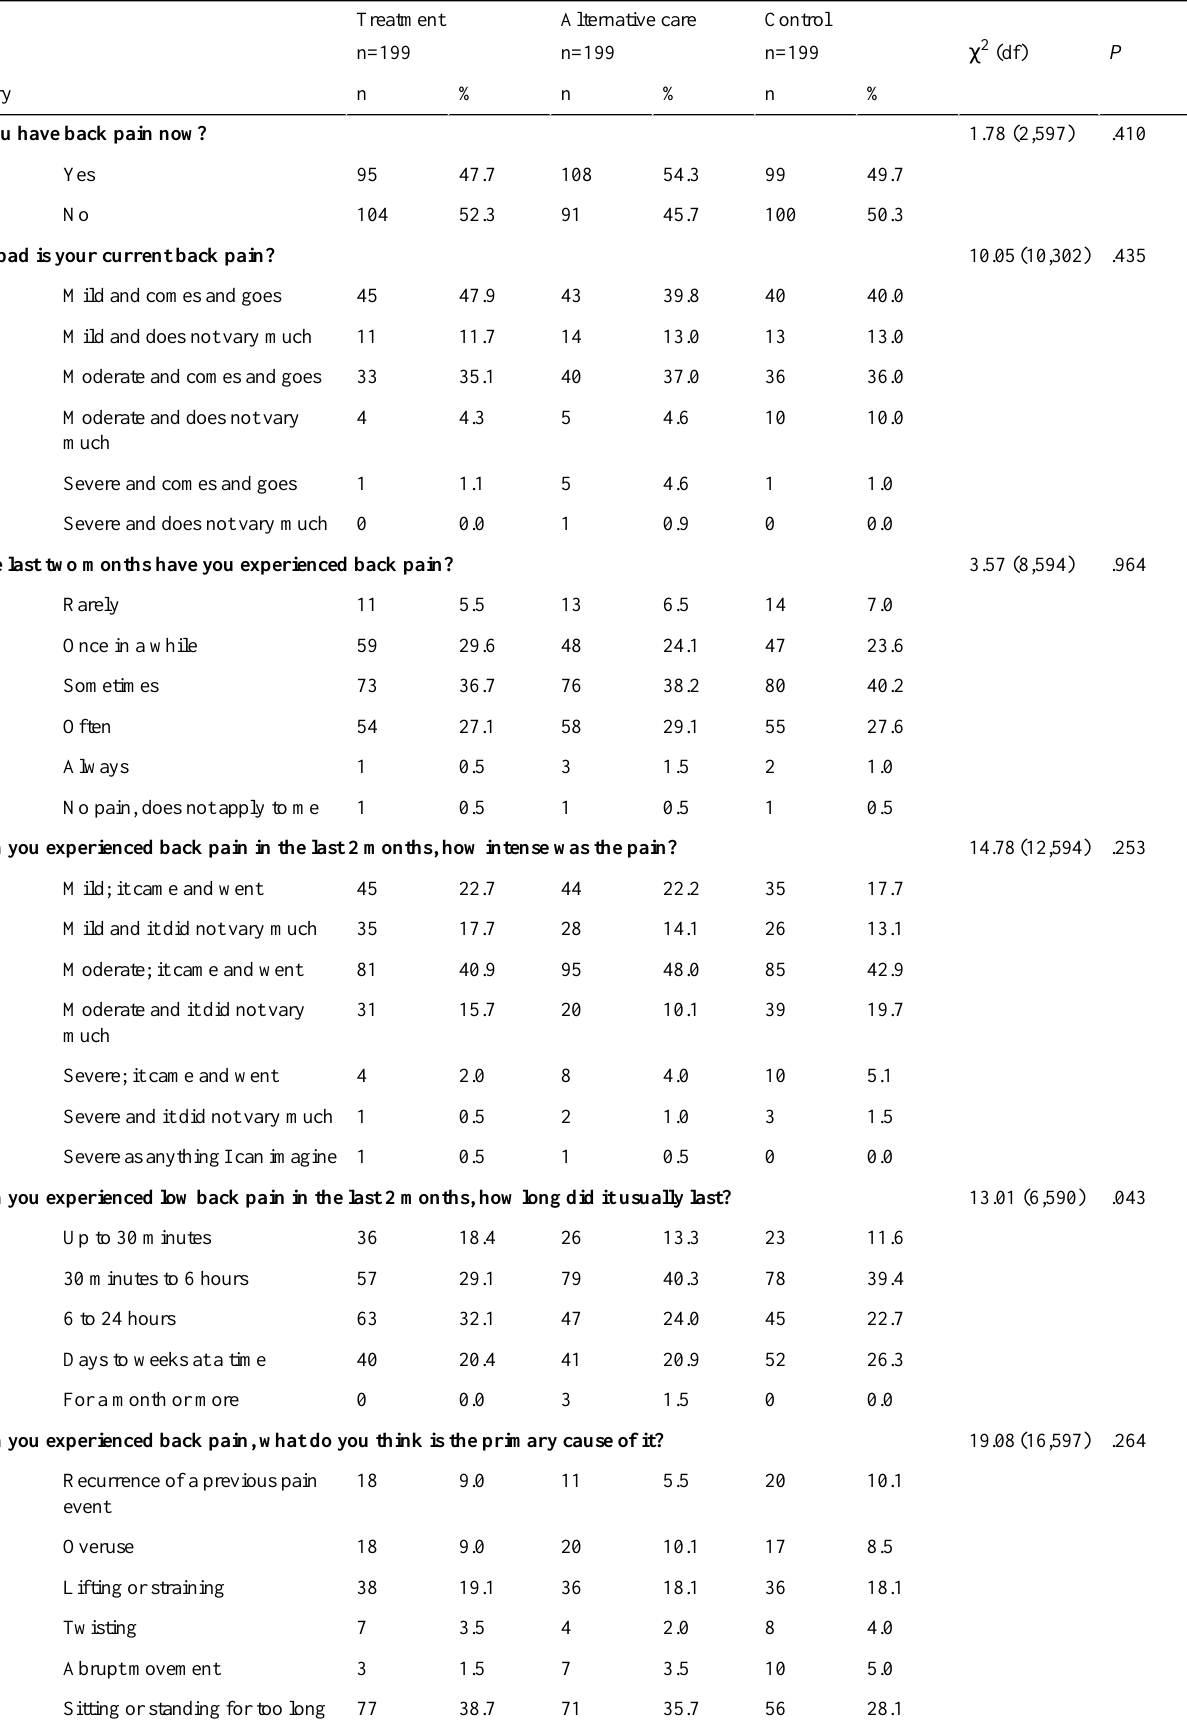
Table 2. History of back